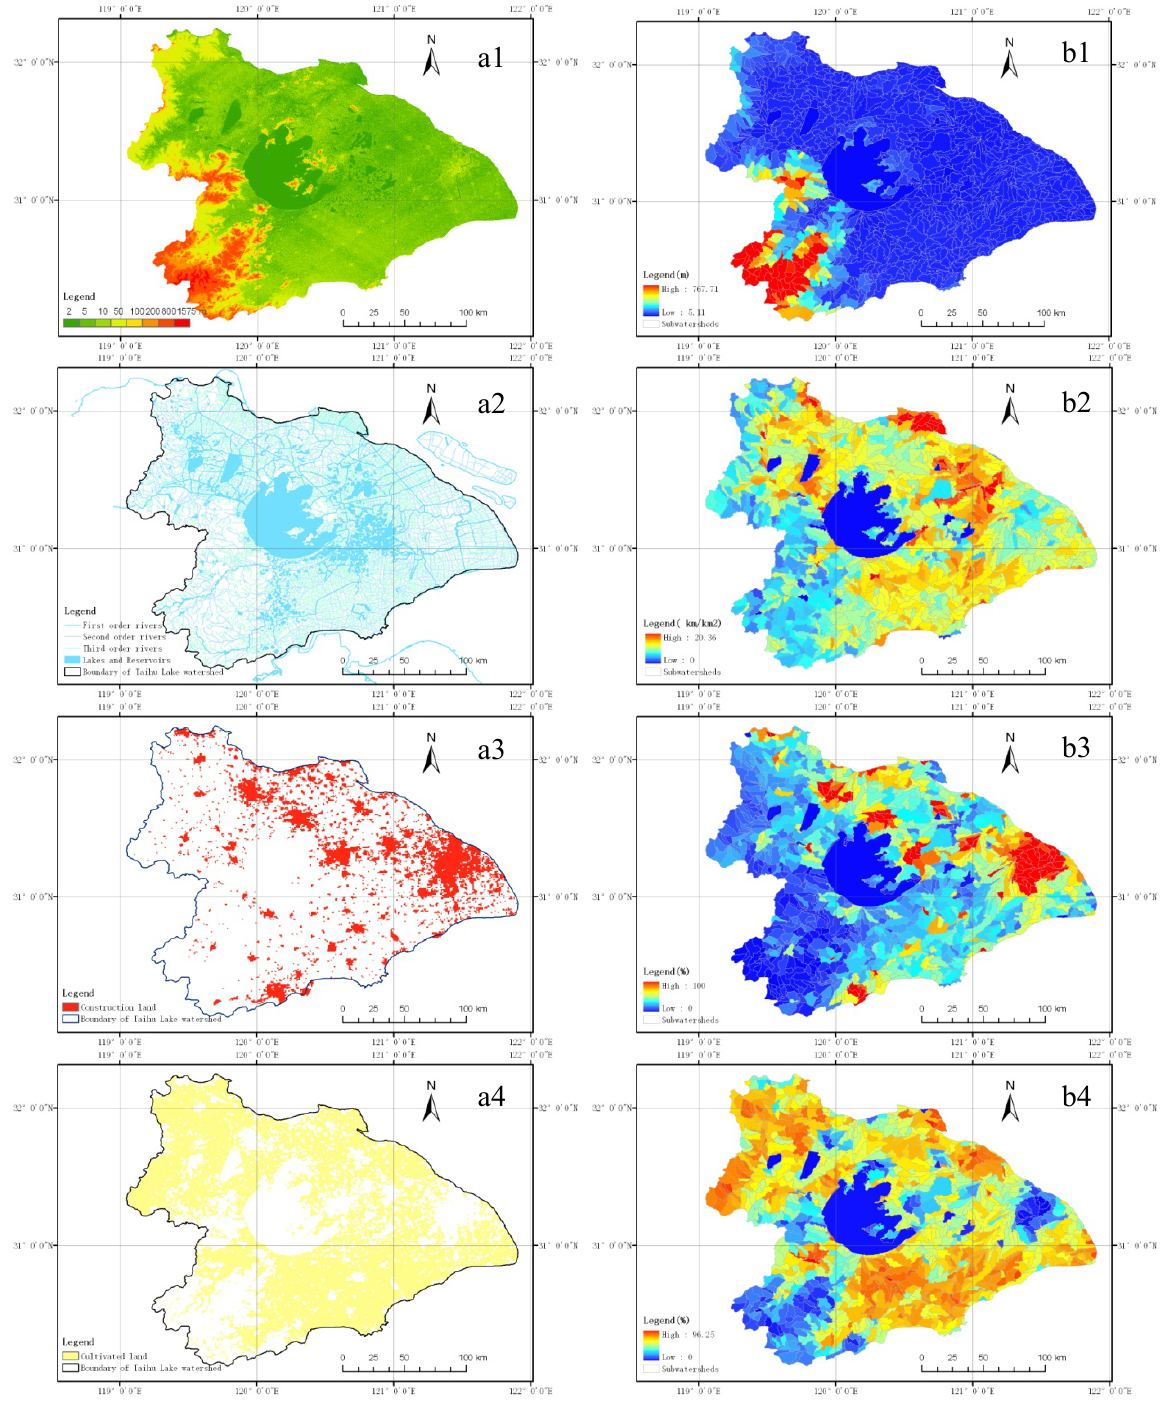
preclustering and (2) hierarchical clustering. The precluster stage groups the respondents into several small clusters. The cluster stage uses the small clusters as input and groups them into larger clusters. Figure 2. Spatial distribution maps of average elevation (a1 and b1), drainage density (a2 and b2), percent of construction land area (a3 and b3), percent of cultivated land area (a4 and b4), soil type (a5 and b5) and slope (a6 and b6) of 90 × 90 m raster units ( a ) and 1,107 subwatersheds ( b ) in the Taihu Lake